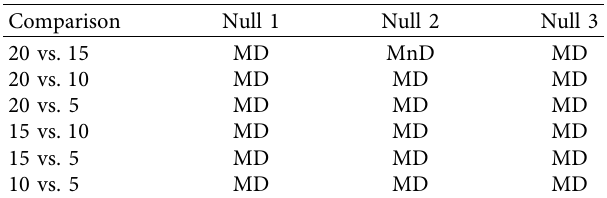
Table 8: Tukey–Kramer comparison test. MD means diferent. MnD means not diferent.